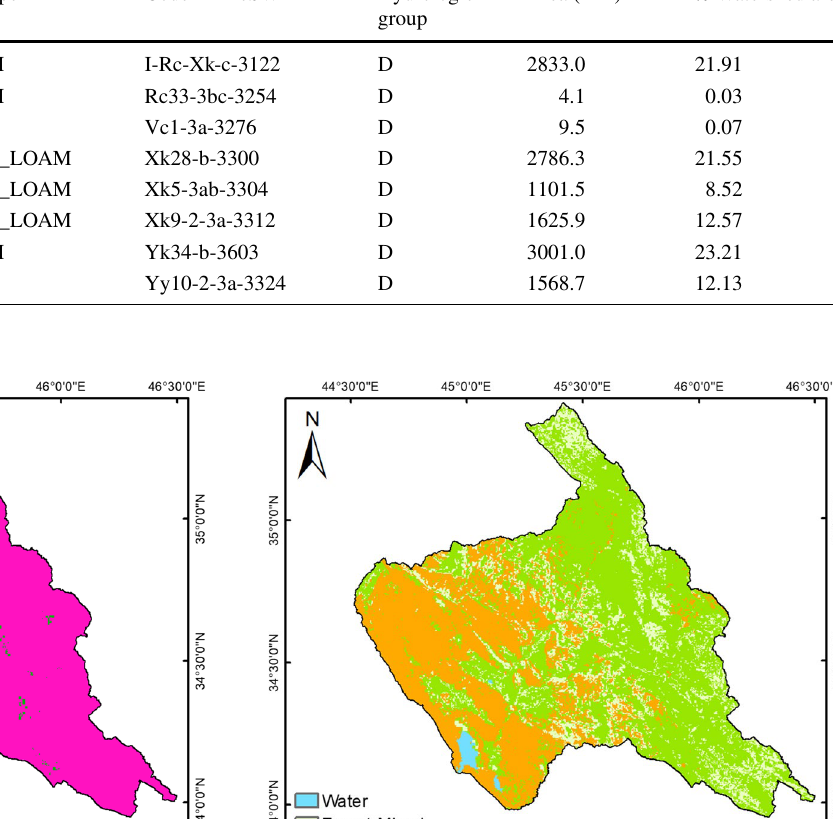
Table 1 Coverage areas of various soil categories in the Hemren dam catchment area